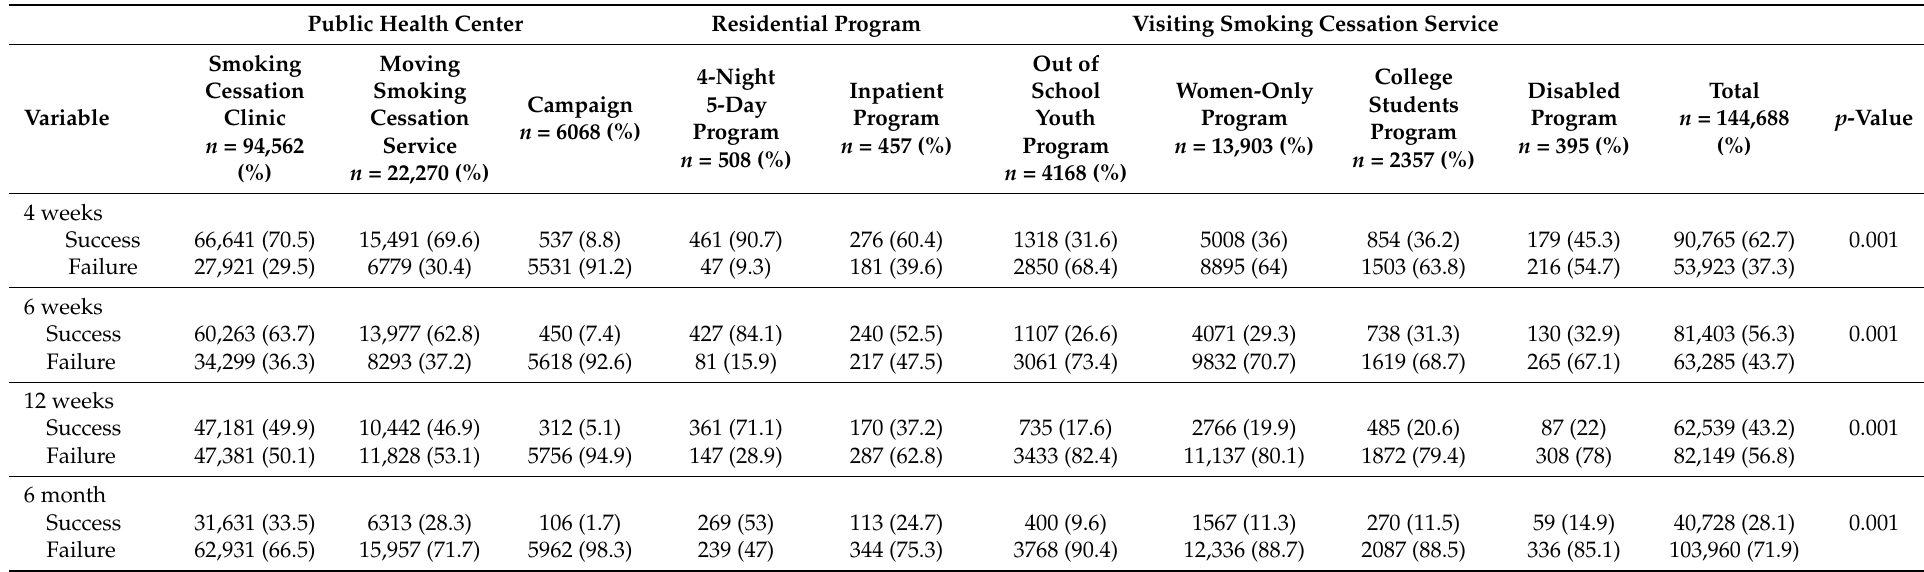
Table 3. Success rate according to various smoking cessation